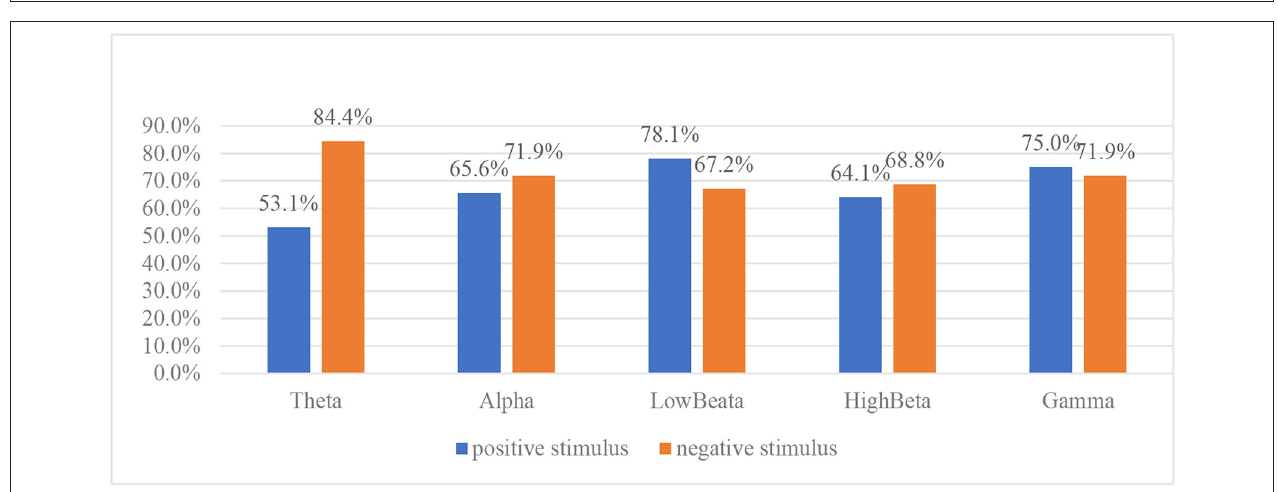
FIGURE 4 | Performance comparison of different rhythm features for typically developing (TD)/autism spectrum disorder (ASD) classification.